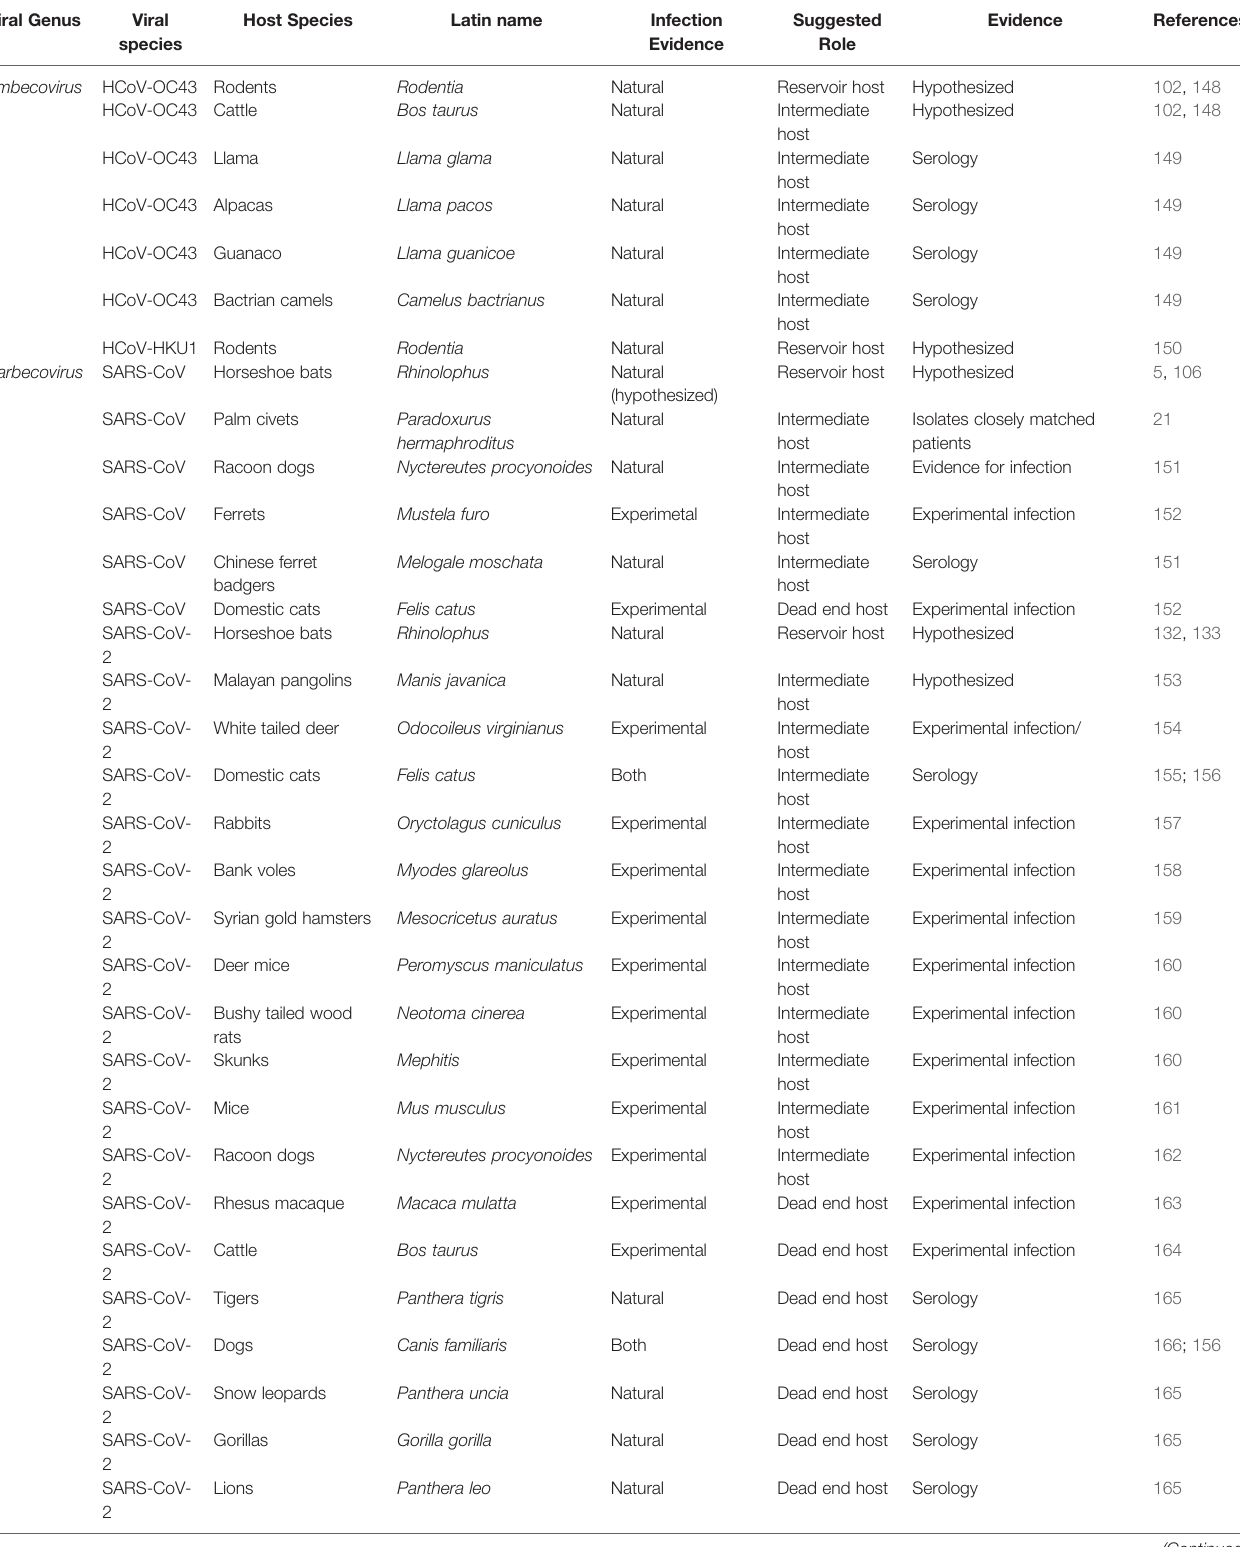
TABLE 1 | Nonhuman animal species identi fi ed to be susceptible to Betacoronavirus infection. Source of evidence, con fi rmation of infection and suggested role in viral transmission are